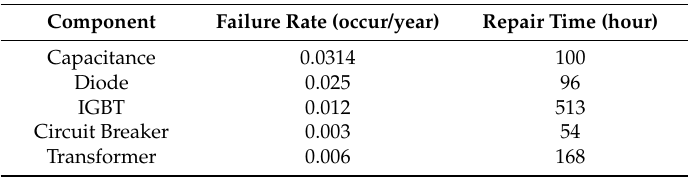
Table 2. Failure and Repair